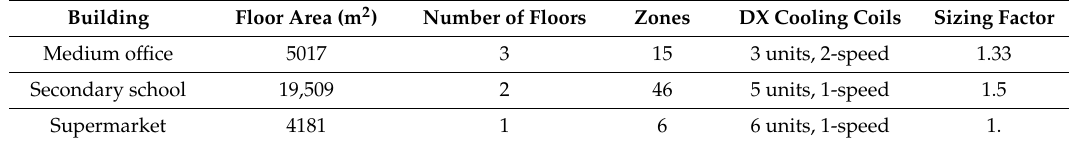
Table 1. Three benchmark commercial buildings selected for this